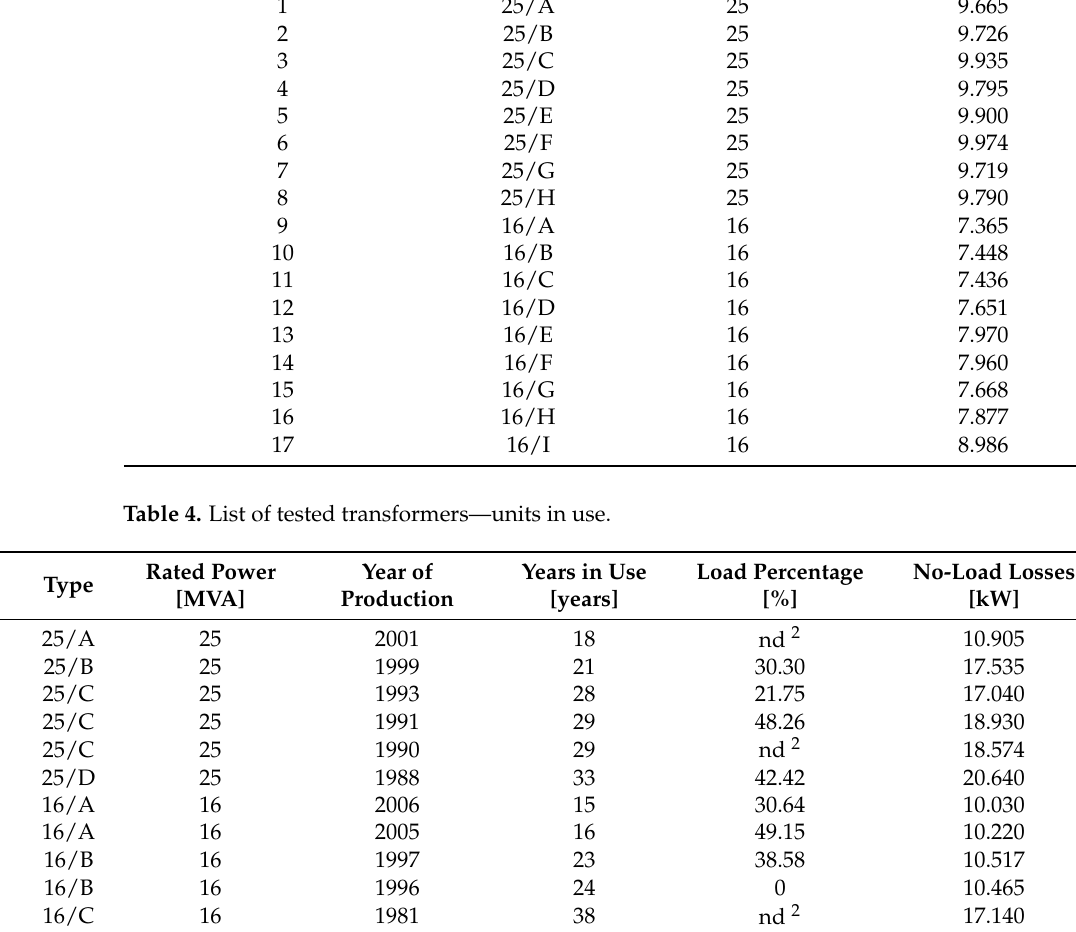
Table 3. List of tested transformers—new units.